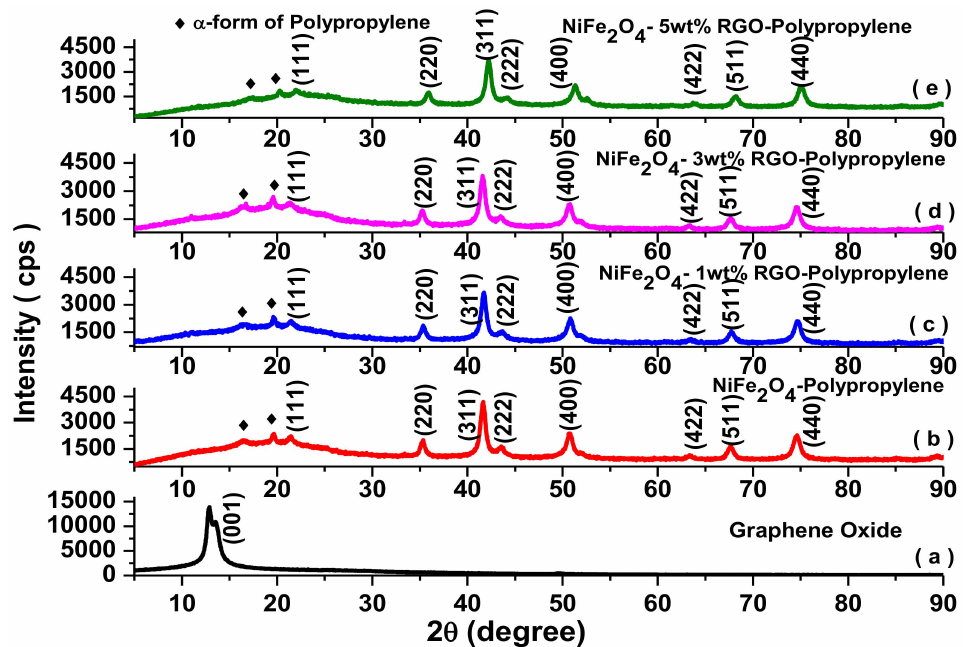
Figure 3. X-ray powder di ff raction patterns of ( a ) graphene oxide, ( b ) NiFe 2 O 4 -Polypropylene ( c ) NiFe 2 O 4 -1wt%RGO-Polypropylene, ( d ) NiFe 2 O 4 -3wt%RGO-Polypropylene, and ( e ) NiFe 2 O 4 -5wt%